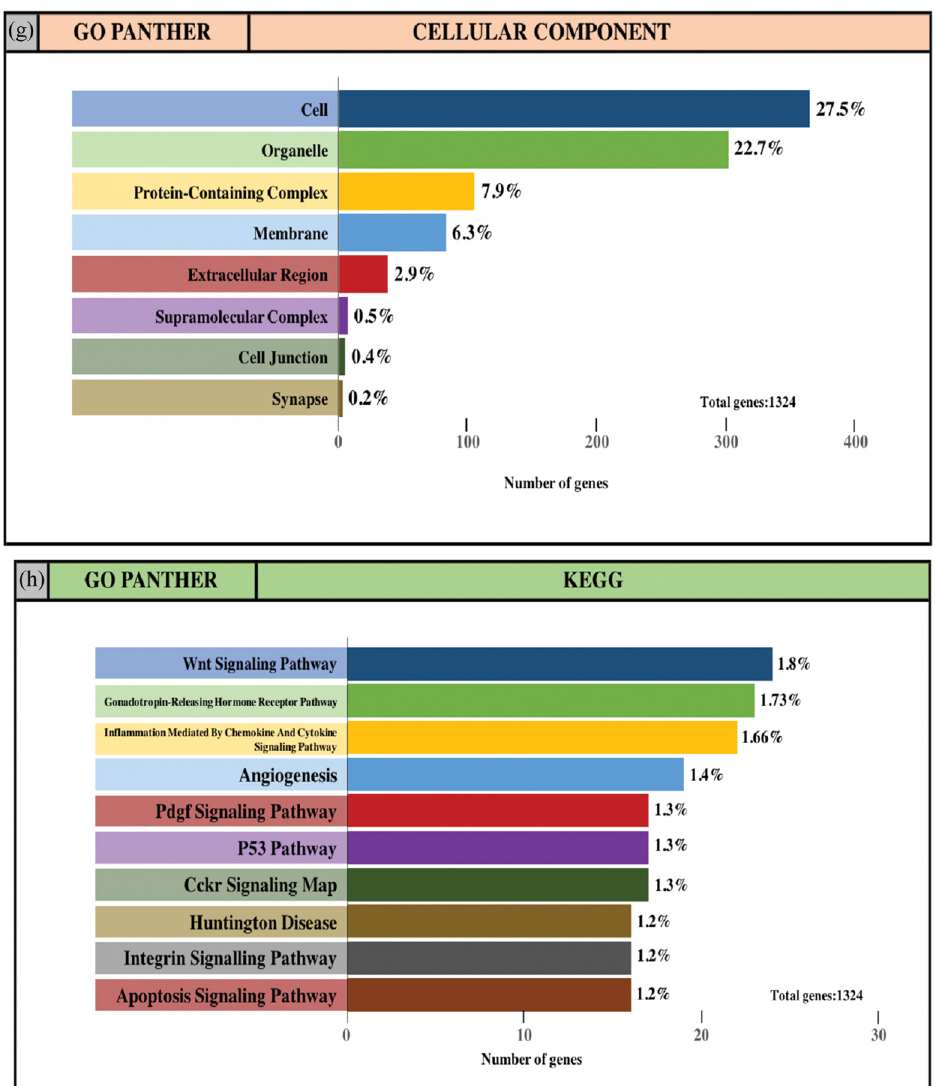
Figure 4: GO and pathway enrichment analysis of the predicted TG of DE - miRNAs through the PANTHER database. ( a and e ) GO PANTHER ’ s analysis on the category of “ biological process ” of the predicted TG of upregulated miRNAs and downregulated miRNAs, respectively. ( b and f ) GO PANTHER ’ s analysis on the category of “ molecular function ” of the predicted TG of upregulated miRNAs and downregulated miRNAs, respectively. ( c and g ) GO PANTHER ’ s analysis on the category of “ cellular component ” of the predicted TG of upregulated miRNAs and downregulated miRNAs, respectively. ( d and h ) GO PANTHER ’ s analysis on the category of “ KEGG ” of the predicted TG of upregulated miRNAs and downregulated miRNAs,